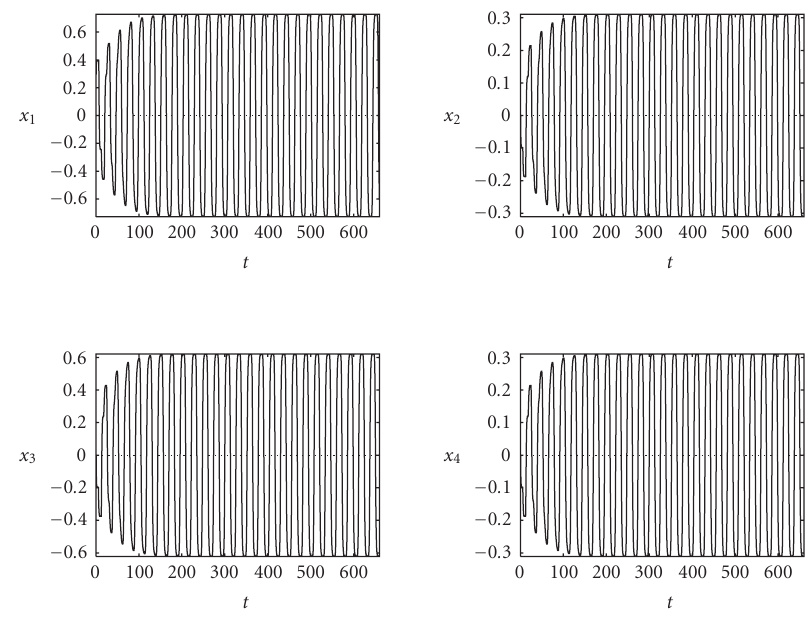
Figure 4.1. The trajectories graphs of system (4.8) with τ 1 = 5 . 45, τ 2 = 6 . 55, and initial data x 1 ( t ) = x 2 ( t ) = x 3 ( t ) = x 4 ( t ) = 0 . 2, t ∈ [ − 6 .